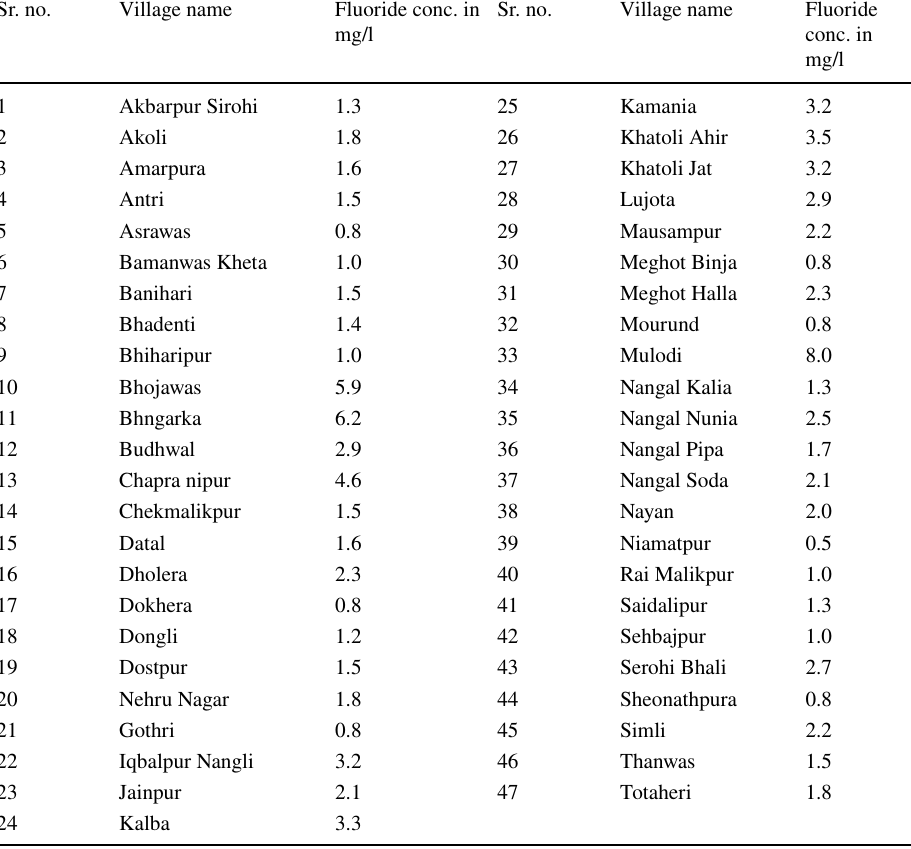
Table 8 Showing the average fluoride concentration in villages of block